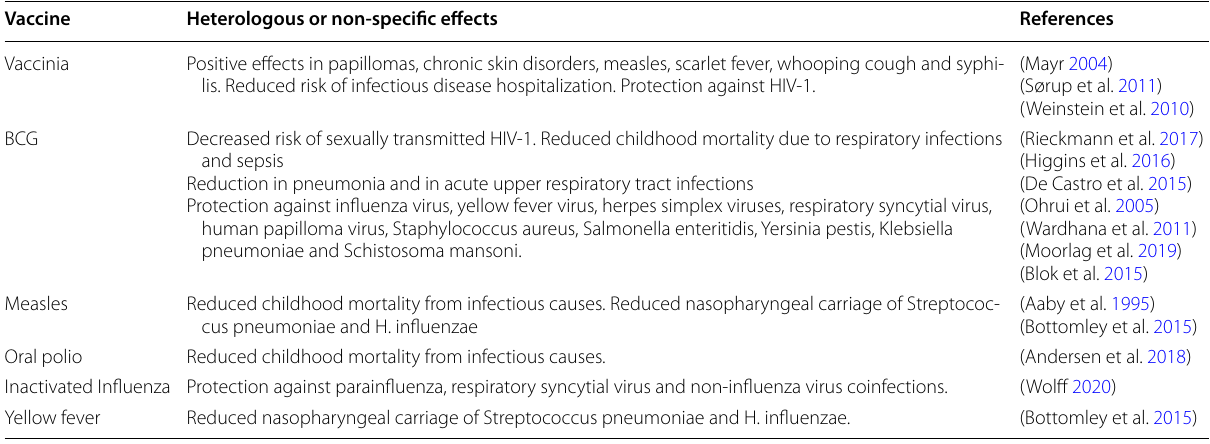
Table 1 Heterologous effects of vaccination Vaccine Heterologous or non-specific